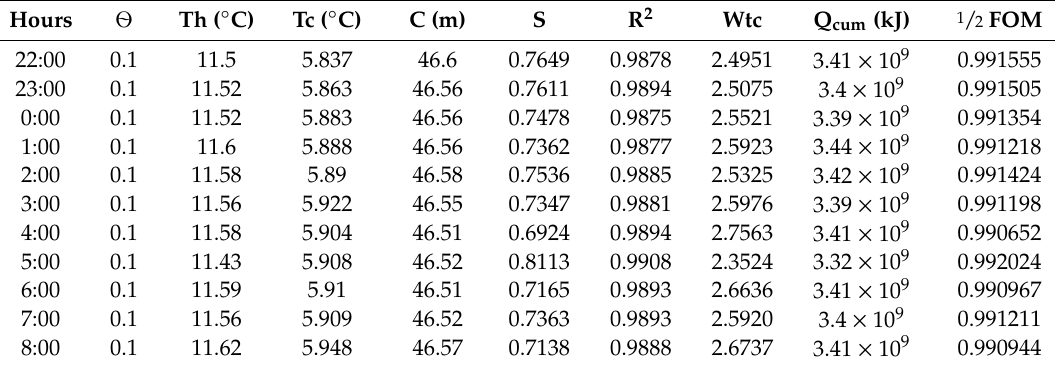
Table A11. 16th–17th October 2019 Curve Fitting and Performance Parameter analysis.